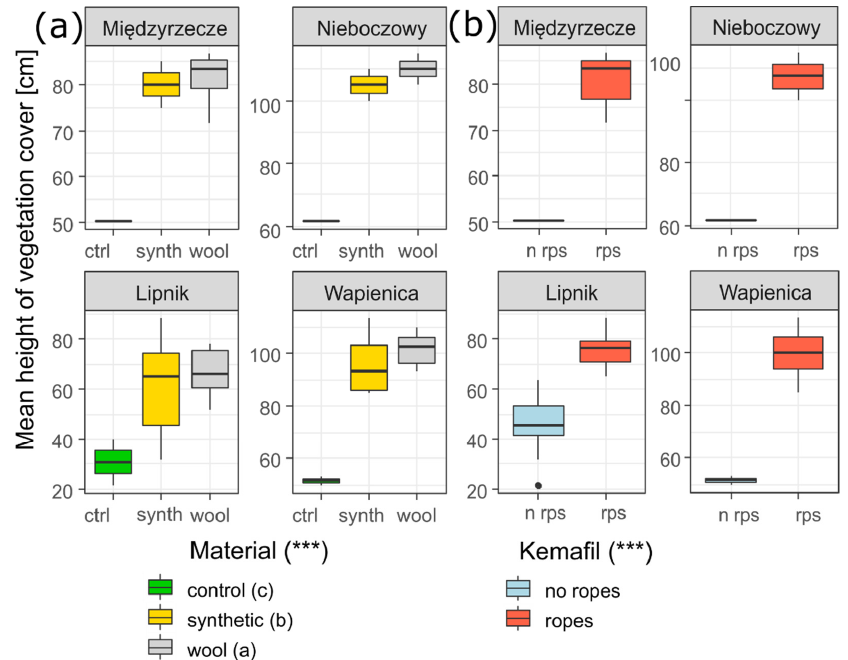
Figure 6. Comparison of the mean value of the height of herb layer in the study plots within and among the sites and among the types of material ( a ) and Kemafil ( b ). Explanation: the ANOVA results refer to a comparison among the material types and between Kemafil types *** p < 0.001, The types of material (indicated by different letters) showed significant differences at p < 0.05 among the groups of plots according to post hoc test LSD Fisher test.